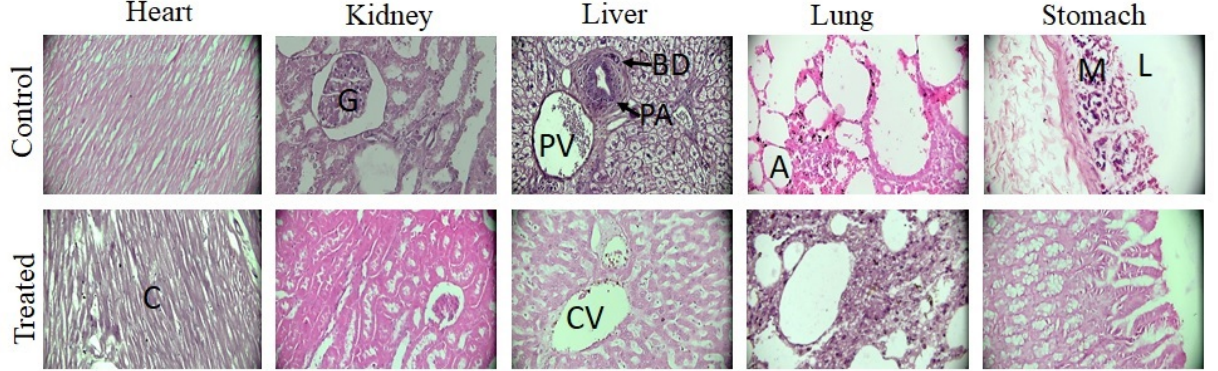
Figure 11. Histopathological images of vital organs of control and group treated with hydrogel after H&E staining. Here, trinocular microscope (Accu-Scope 3001) with a built-in five megapixel camera was used to take images at 40×. Alphabets in micrographs are designated as “C” for cardiomyocytes of heart, “G” for glomerulus of kidney, “CV” for central vein of liver, “PV” for portal venule, “PA” for portal arteriole, “BD” for bile duct, “A” for alveolar sacs of lung, “L” for lumen, and “M” for mucosa of stomach.